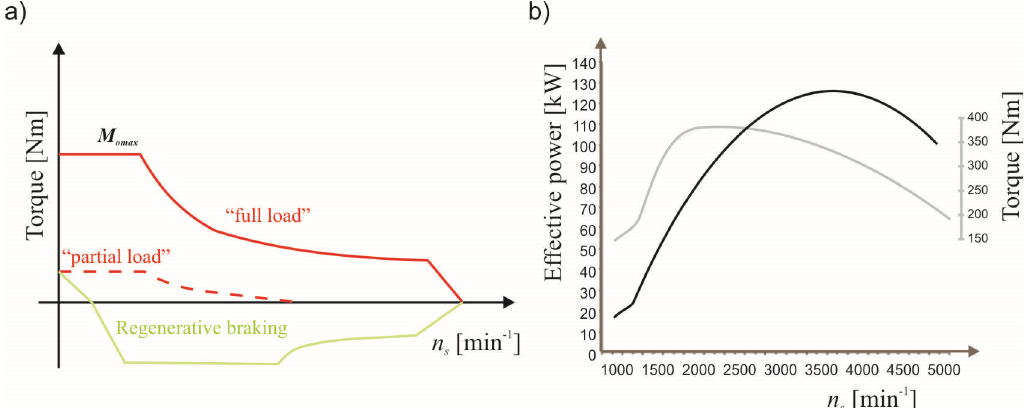
Figure 3. Speed characteristics of electric ( a ) and the Renault–Nissan group M9R internal combustion ( b ) diesel engine for full load conditions [6]; n—rotational speed of the engine crankshaft.